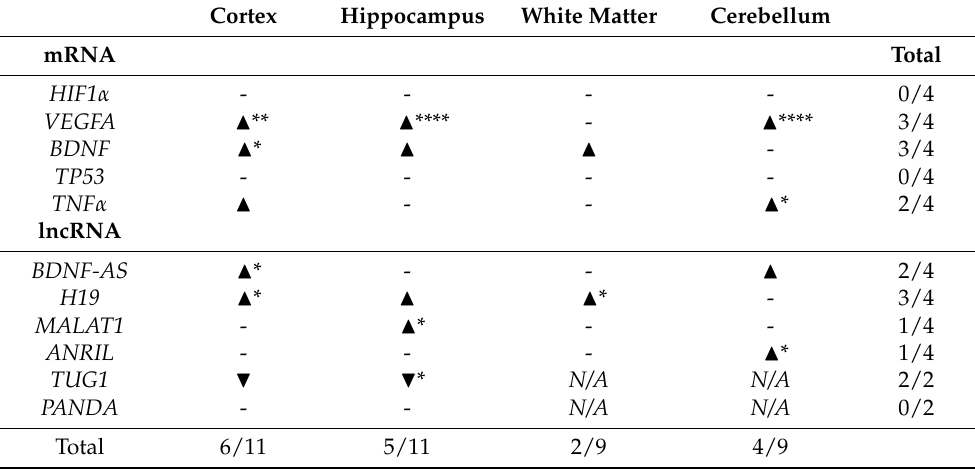
Table 3. Summary of gene expression variations and significance across various brain regions in a perinatal asphyxia piglet model. Gene expression was measured in samples from the cortex, hippocampus, white matter, and cerebellum in piglets exposed to severe hypoxia (8% O 2 ) and reoxygenated with 21% oxygen (Reox-21%), relative to the sham-operated control group (Figure 2 and Supplementary Figure S1). Cortex Hippocampus White Matter